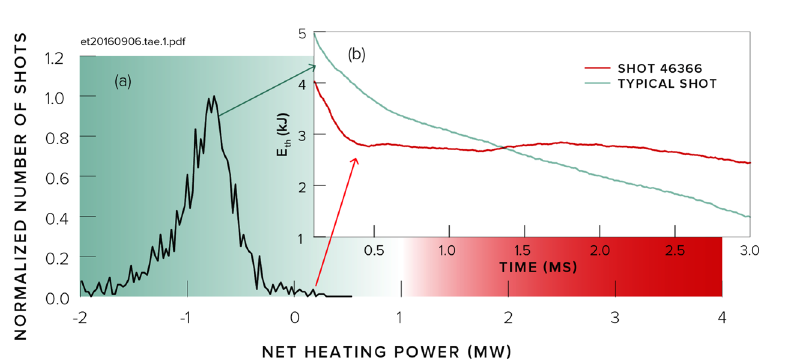
Figure 3. ( a ) Normalised distribution of the number of shots as a function of net heating power in C-2U based on over 1800 shots with at least 2 kJ of stored thermal energy ( E th ). Typical power losses are between 0.6 and 1 MW. Power is taken as the peak value in a rolling 1 ms time window between 1 and 3 ms. ( b ) Net power into the plasma exceeded 0.1 MW in Shot 46366 due to a reduction in cooling